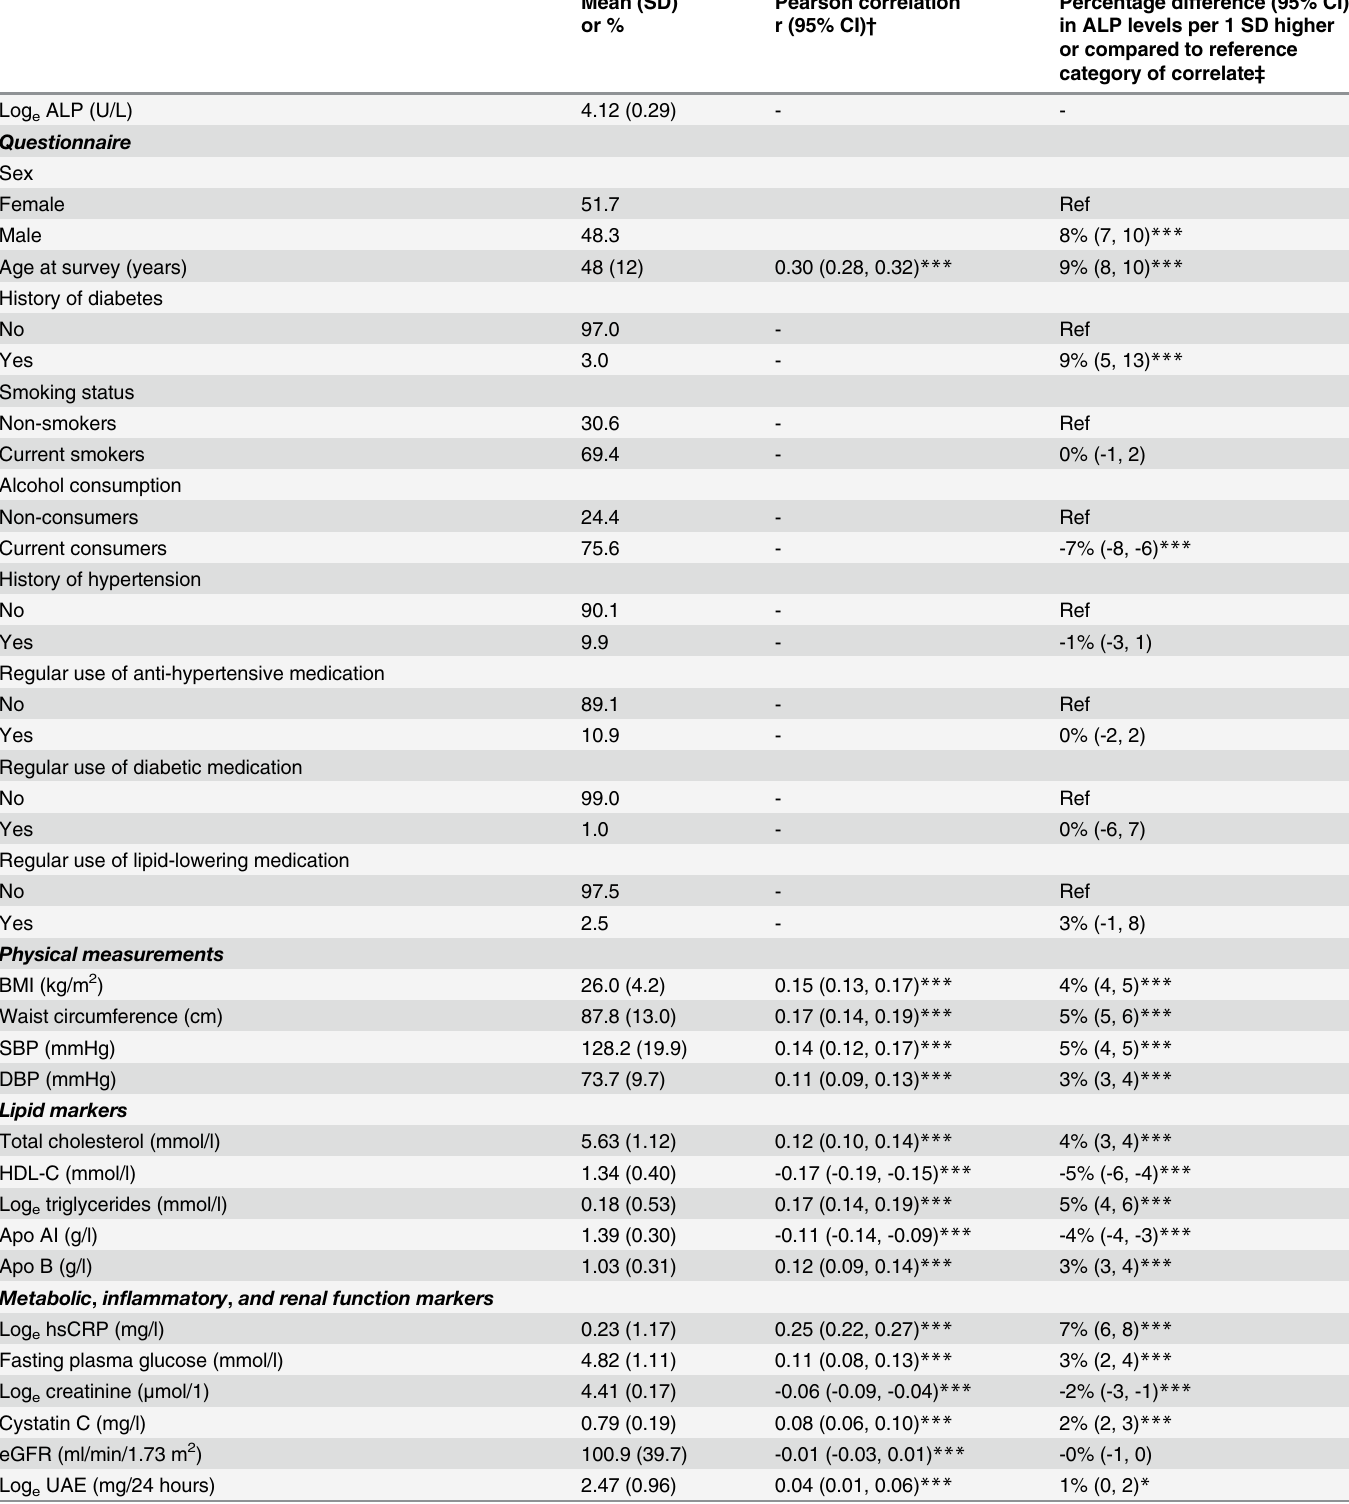
Table 1. Baseline participant characteristics and cross-sectional correlates of alkaline